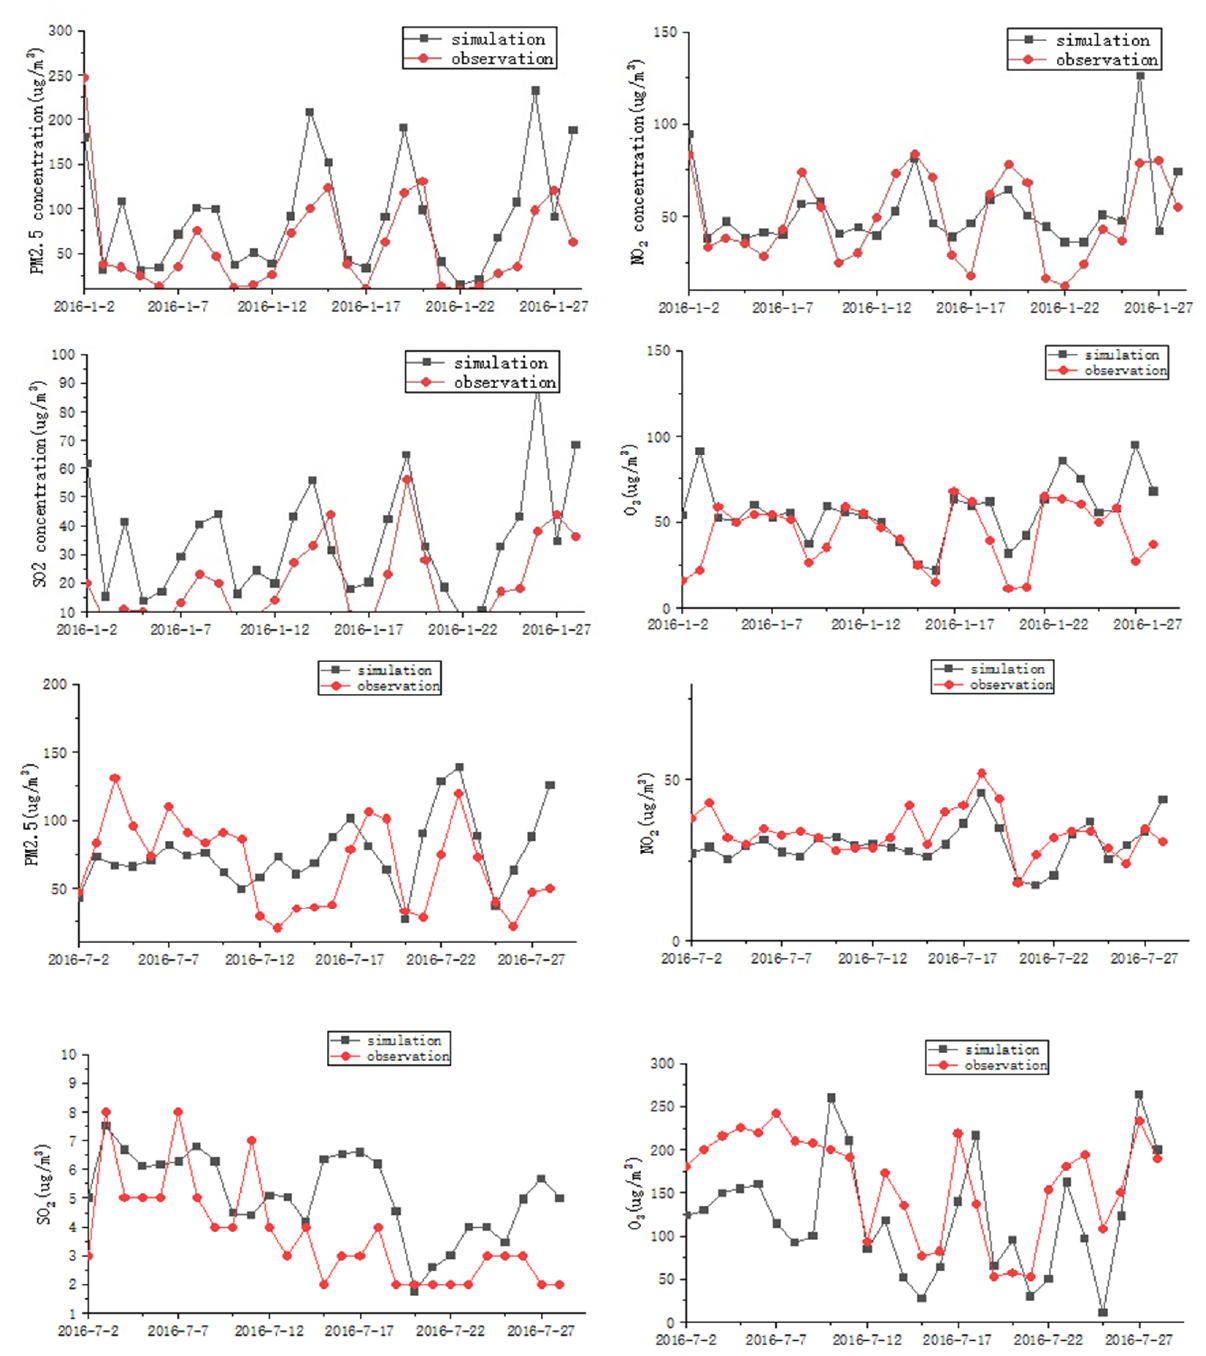
Figure 2. Comparison of the simulated results with the observed data.